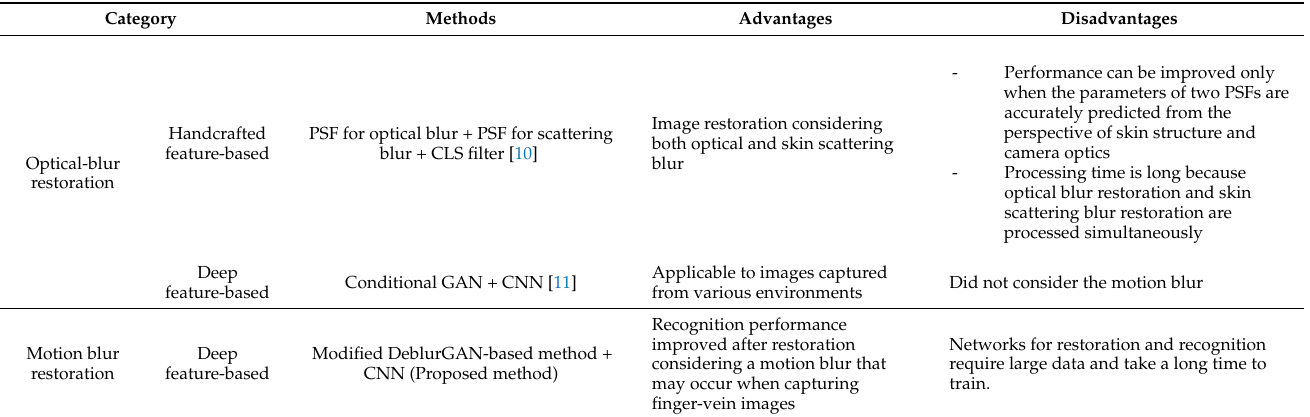
( d ) Figure 2. Example of background removal and in-plane rotation compensation: ( a ) original image; ( b ) binarized image; ( c ) background removed image; ( d ) in-plane rotation compensation. Note that 𝑓(𝑥, 𝑦) and (𝑚 (cid:3051) , 𝑚 (cid:3052) ) represent image pixel values and central coordi- nates, respectively. Based on these values, the rotation angle  , in Equation (2) is calcu- lated to compensate for the in-plane rotation [30]. The compensated image, shown in Fig- ure 2d, is obtained from this process.